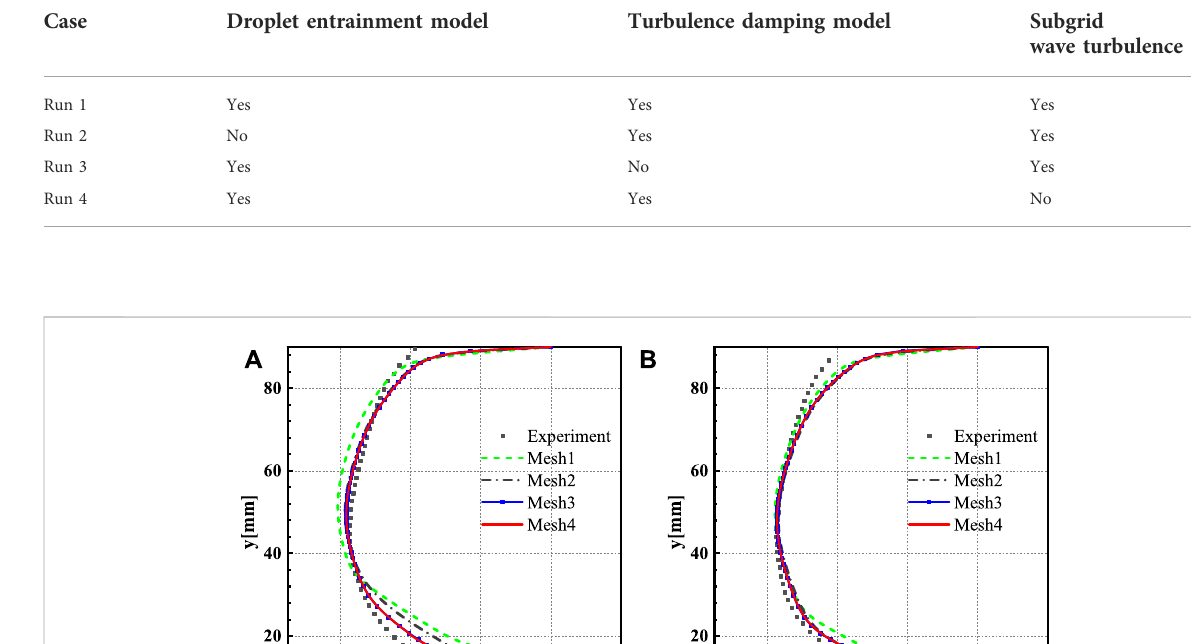
TABLE 2 Overview of the performed simulations.